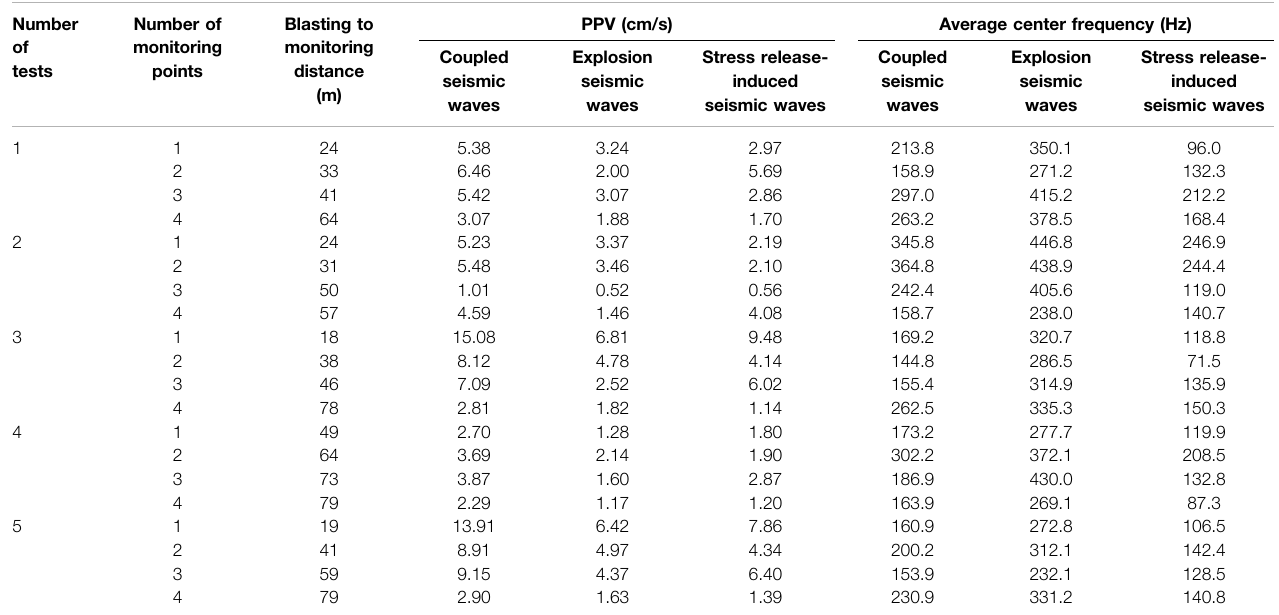
TABLE 3 | PPV and average center frequency of the separated seismic waves. Number